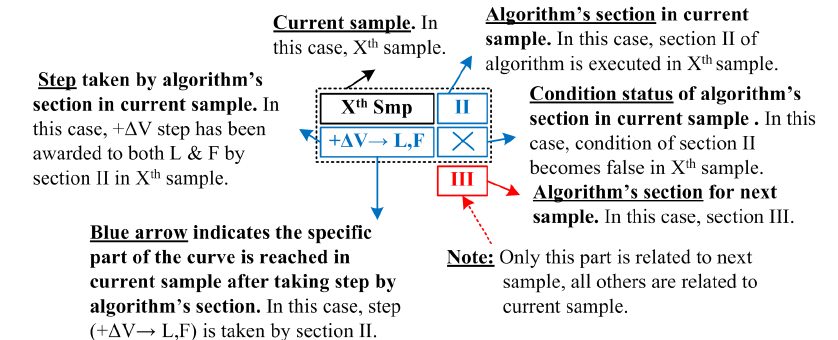
Figure 5. Group notations understanding.